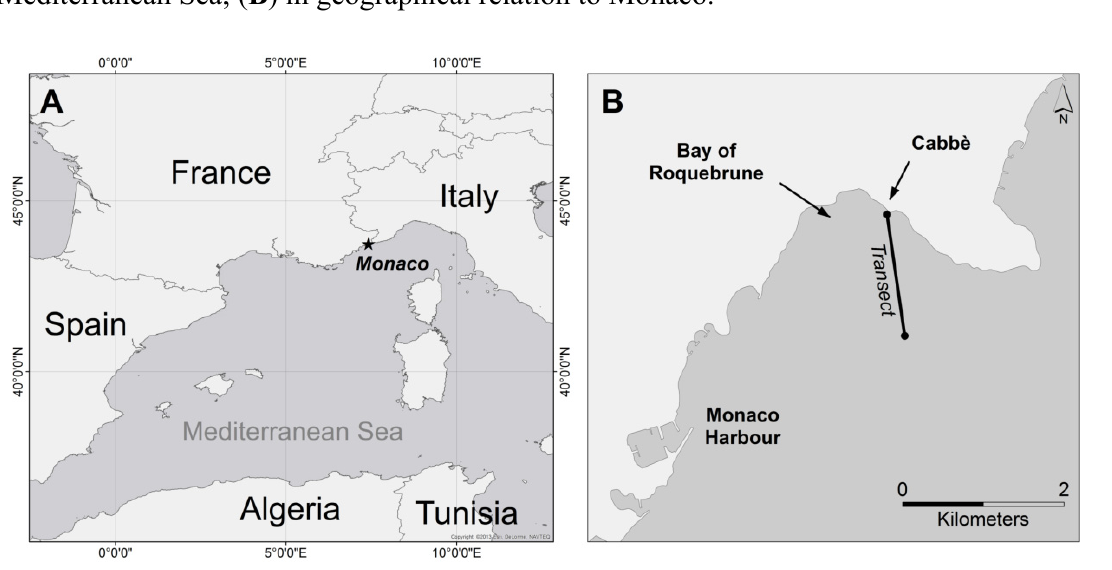
Figure 2. Regional setting of the site and the measured transect ( A ) within the Mediterranean Sea; ( B ) in geographical relation to